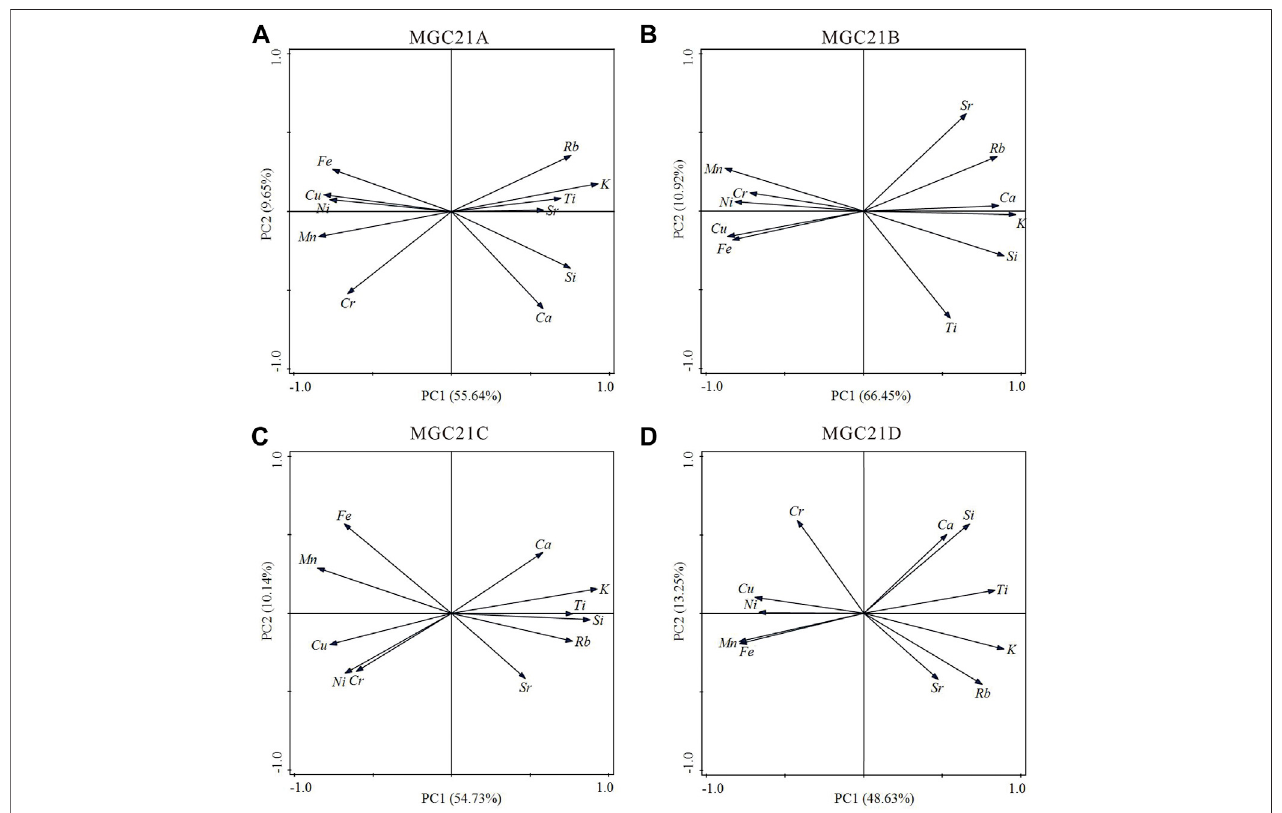
FIGURE 4 | PCA results in the cores MGC21A (A) , MGC21B (B) , MGC21C (C) , and MGC21D (D) .